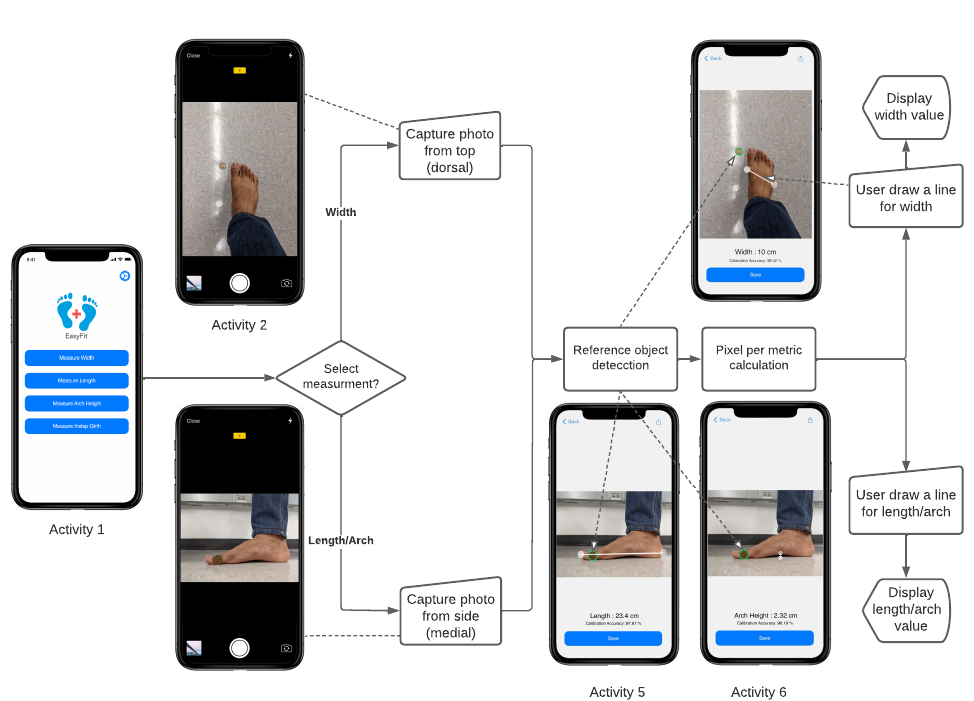
Figure 5. Activity diagram for the measurements of length, width, and arch